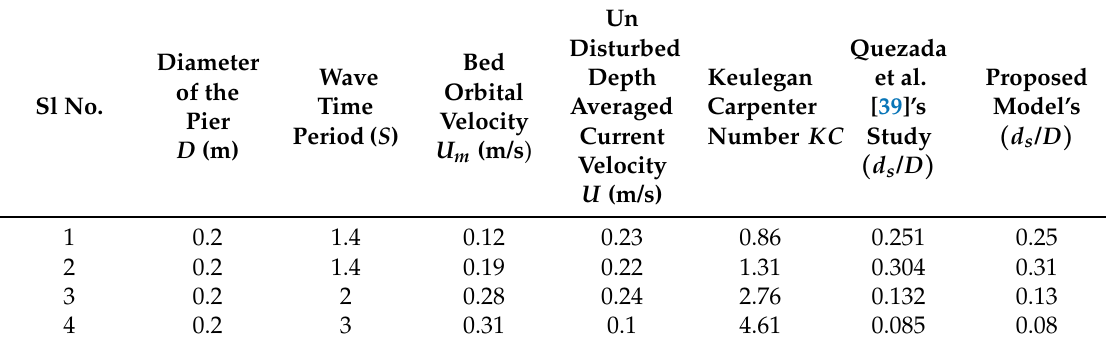
Table 2. Comparison of the calculated non-dimensional scour depth ( d s / D ) with the corresponding values obtained from the numerical studies of Quezada et al.